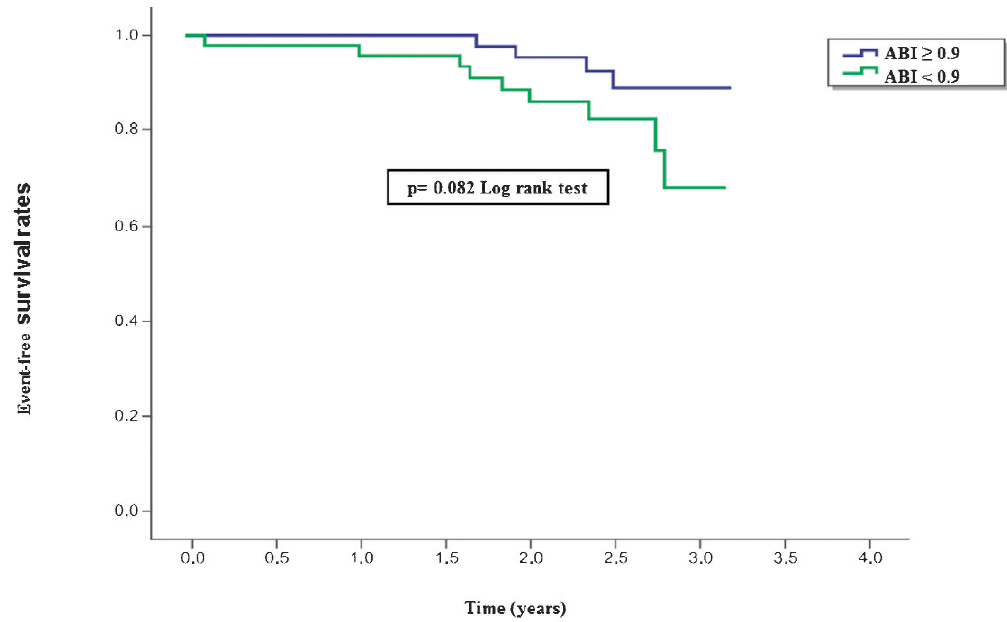
Figure 2 - Event-free survival by ABI categories. Kaplan-Meier estimates showing AMI during the follow-up visit.